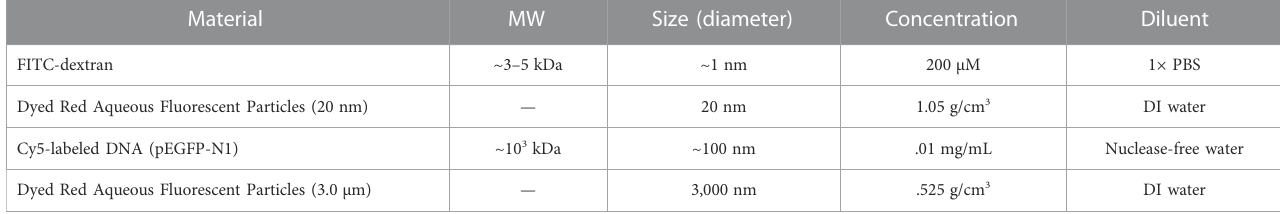
TABLE1Summaryofmolecularcargoinformation.ThediameterofCy5-labeledDNAismeasuredtobe99.83±14.45 nm(n=27)perourexperiment,whereasthesizes of FITC-dextran and fl uorescent particles are adopted from prior work (Latulippe and Zydney, 2010) and provided by manufacturer, respectively. Material